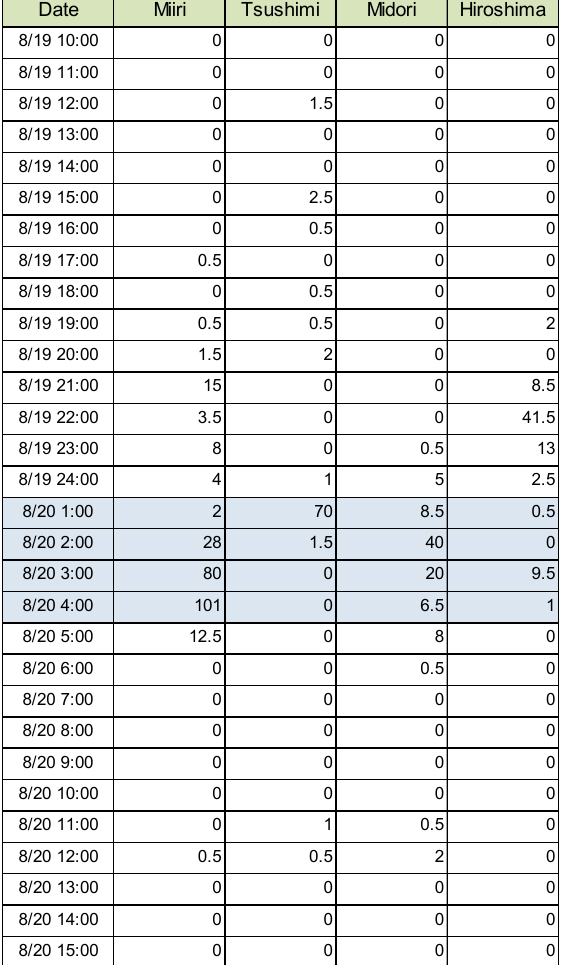
Table 1. Hourly precipitation measured by JMA AMeDAS